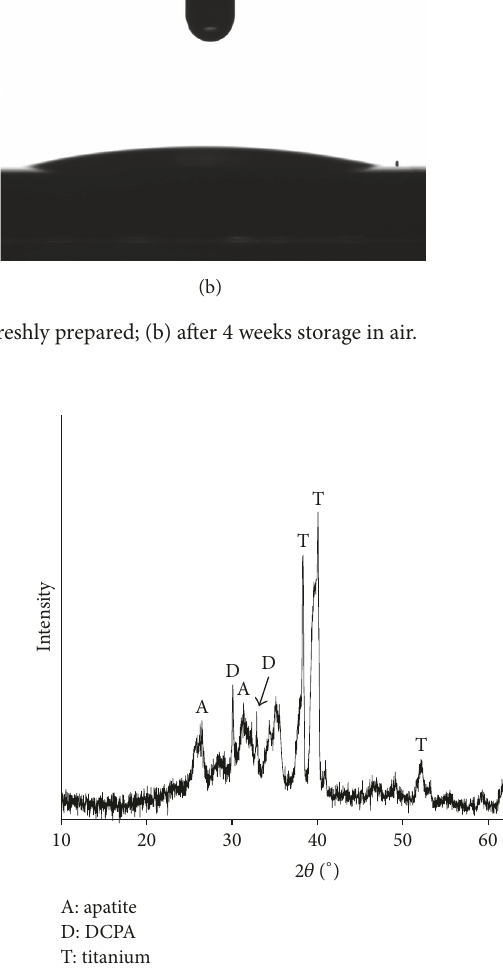
Figure 9: Phase analysis of coated specimens after being immersed in SBF for 2